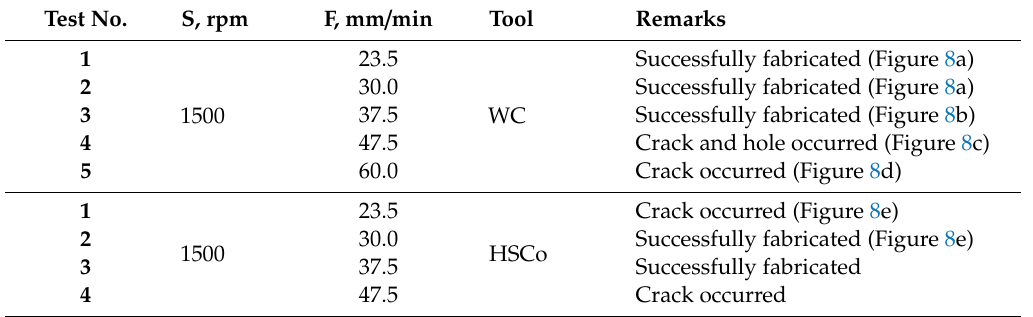
Table 6. Fabrication of 2219 Al-Cu (1.65 mm) lap joint using WC and HSCo square-pin tool (T D : 22 s). Test No. S, rpm F, mm /